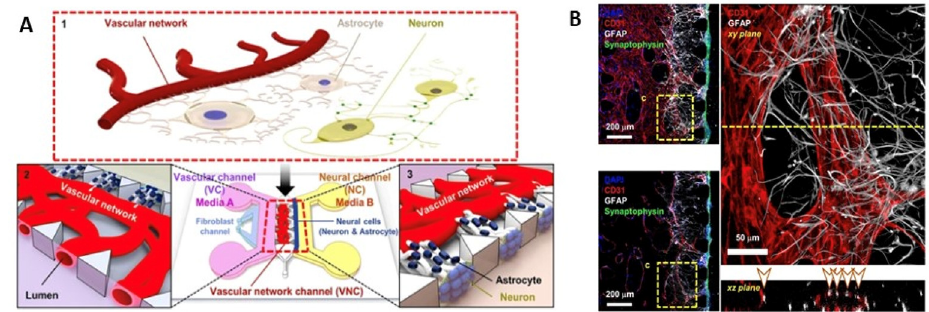
Figure 6. Self-assembled vasculatures of the BBB designed by the vasculogenesis approach. ( A ) The design depicts self-assembled endothelial cell vasculature in conjunction with astrocytes that harbors neuronal cells. The media for vascular channel and neural channel are supplied through side flanks. ( B ) Immunohistochemistry of vascular networks demonstrating astrocytes and vascular channel interface. Astrocytes end feet seen on the neuronal layer is spread at the surface of vascular channel which stops after the interface. (Source: Reprinted from Bang, S.; Lee, S.-R.; Ko, J.; Son, K.; Tahk, D.; Ahn, J.; Im, C.; Jeon, N.L. A low permeability microfluidic blood–brain barrier platform with direct contact between perfusable vascular network and astrocytes. Sci. Rep. 2017 , 7 , 1–10, [181], under